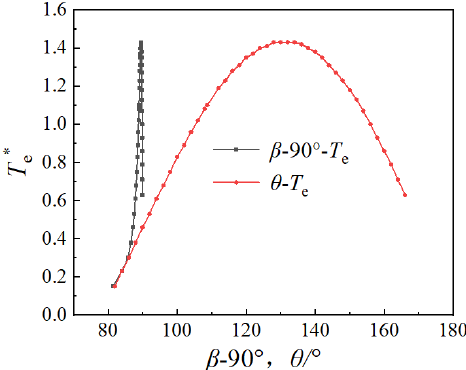
Figure 12. The curve of per unit value of torque at λ = 0.2.